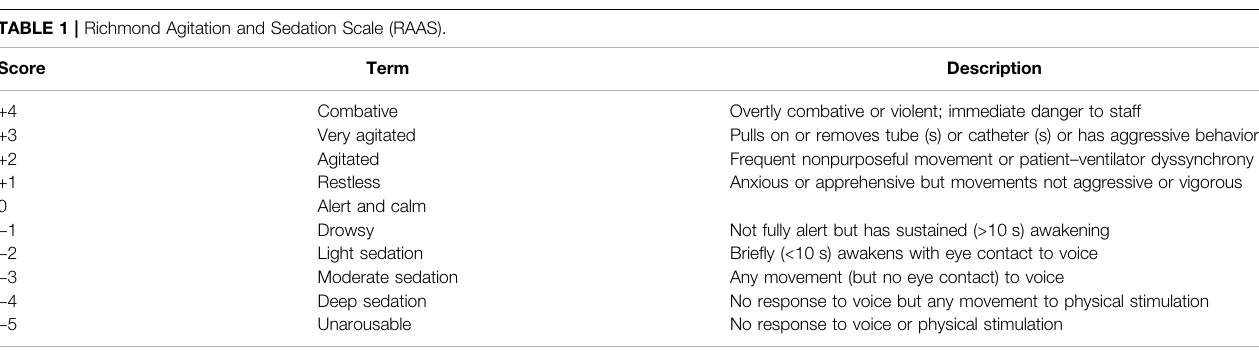
TABLE 1 | Richmond Agitation and Sedation Scale